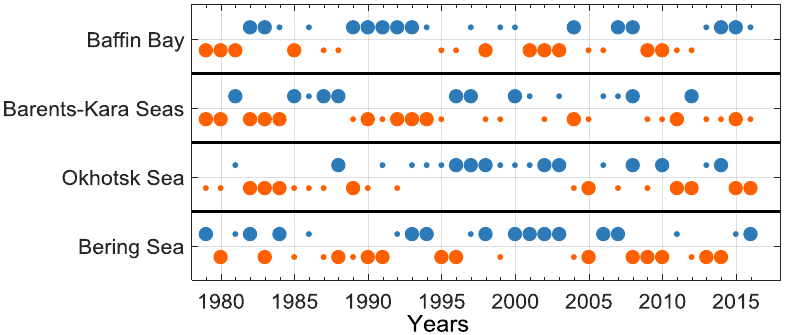
Figure 4. High (blue circles) and low (orange circles) regional averaged winter SIC for regions Baffin Bay, Barents-Kara Seas, Okhotsk Sea and Bering Sea. The regional mean SIC time series are all detrended and normalized. Large (small) blue circles represent the winters with SIC higher than 0.5 (0.0) standard deviation. Large (small) orange circles represent the winters with SIC lower than −0.5 (0.0) standard deviation.